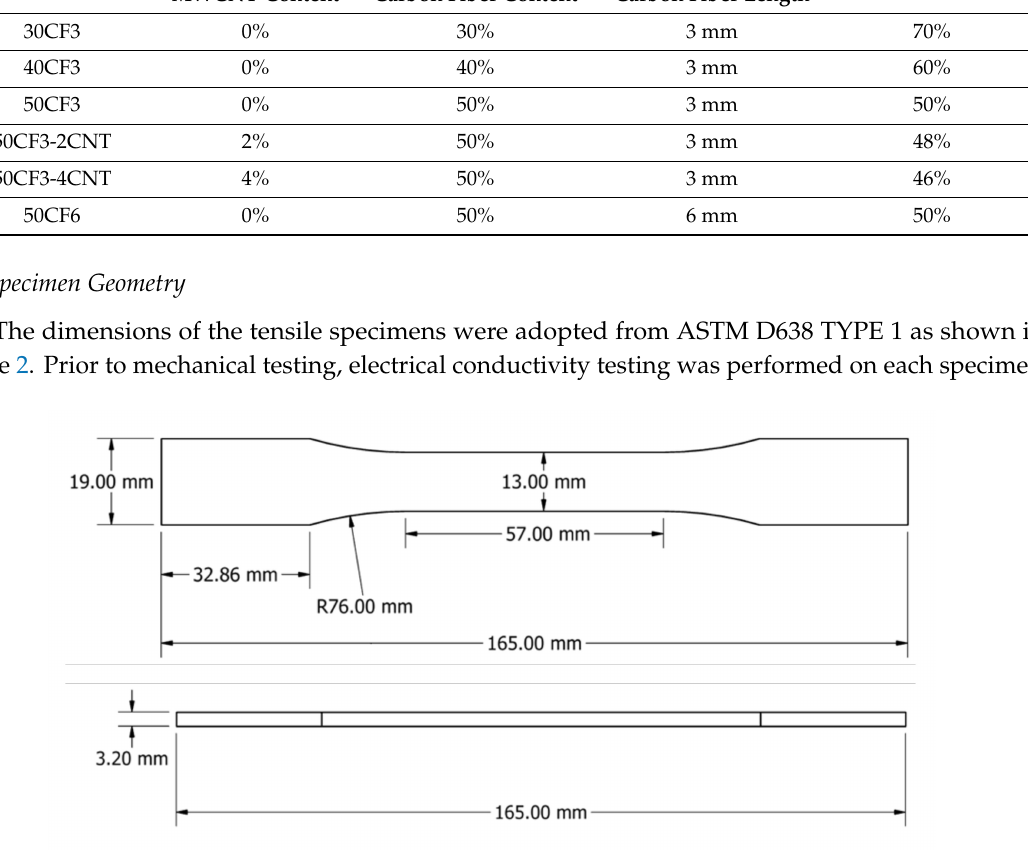
Figure 2. Tensile testing coupon dimensions designed based on ASTM D638 TYPE